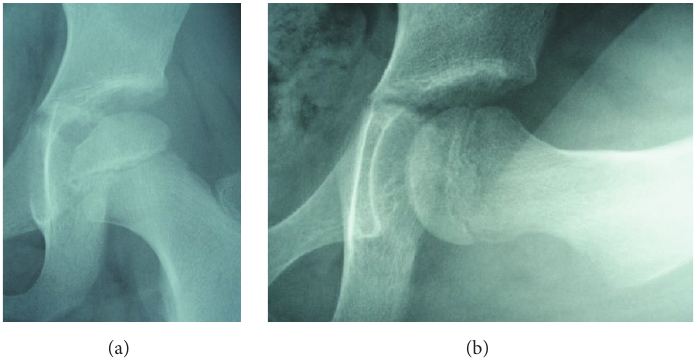
Figure 1: Plain radiographs of the hip joints at the initial visit. (a) Anteroposterior image. (b) Lateral image. No abnormalities were observed.